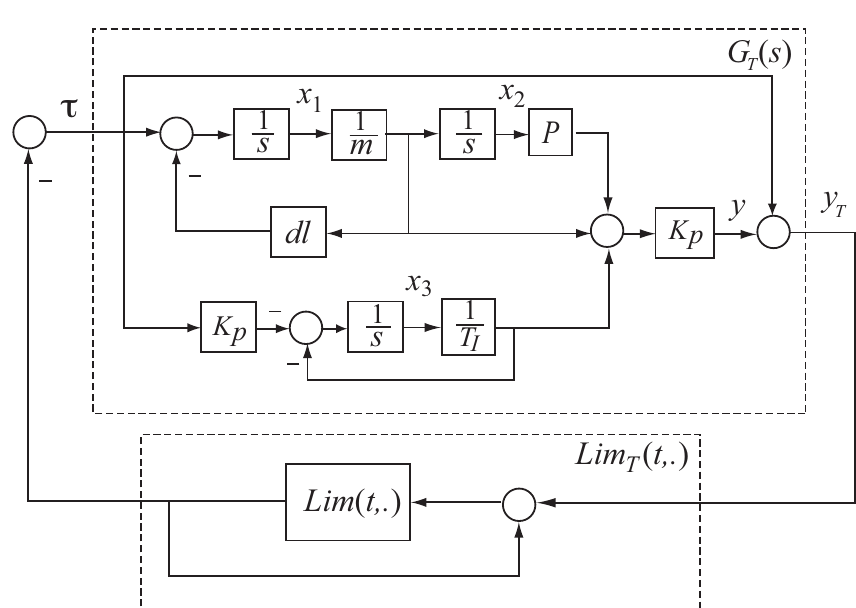
Figure 6: Loop transformation of the control